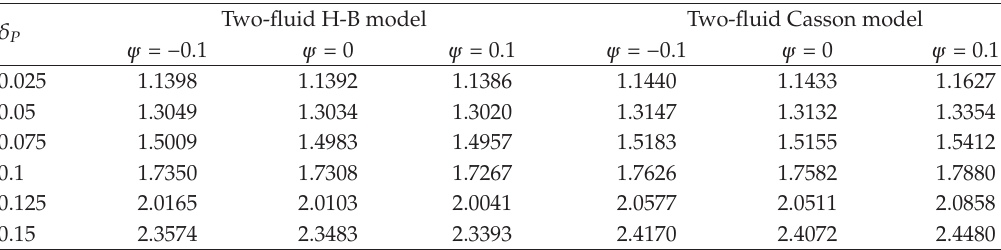
Table 1: Estimates of the increase in the longitudinal impedance to flow due to the increase in the maximum depth of the stenosis for two-fluid H-B and Casson models and for di ff erent angles of tapering with B (cid:7) 1, t (cid:7) 60 ◦ , β (cid:7) n (cid:7) 0 . 95, θ (cid:7) 0 . 1, φ (cid:7) α (cid:7) α H (cid:7) α C (cid:7) 0 . 2, z (cid:7) 2 . 3, e (cid:7) 0 . 5, ω (cid:7) 1, and b (cid:7) 0 . 1.